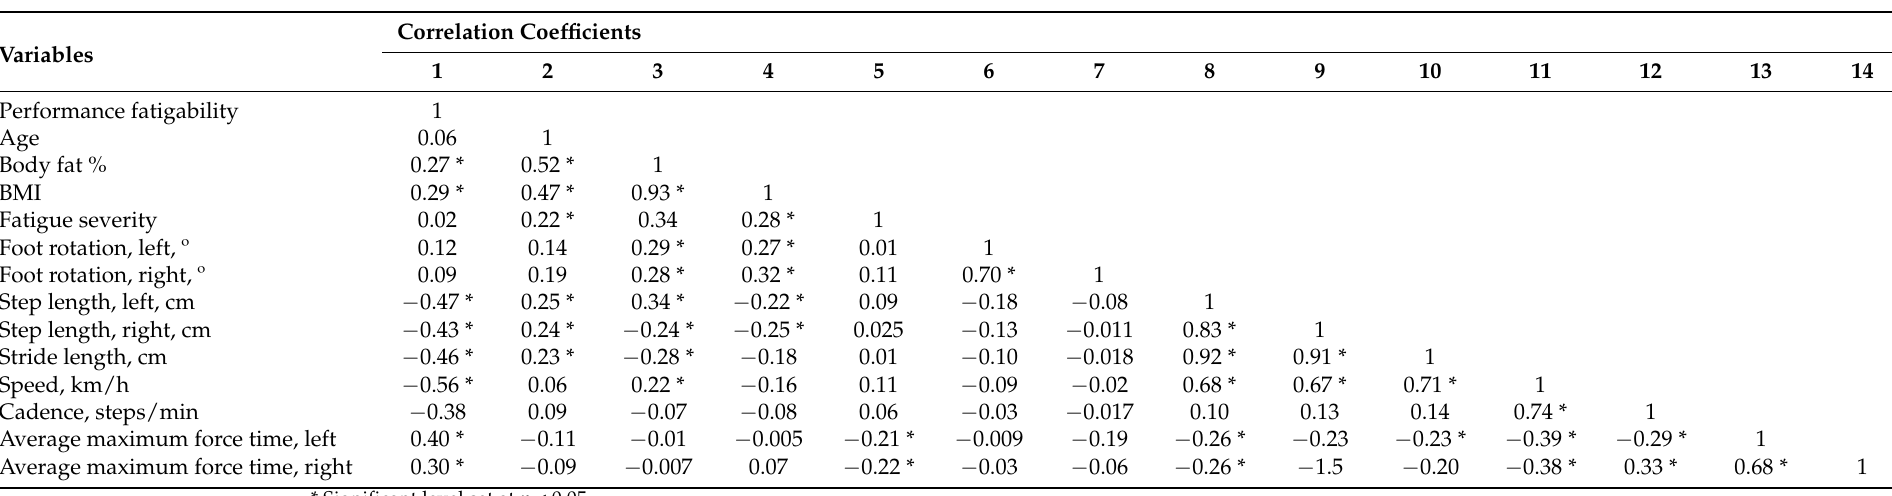
Table 4. A matrix of the Pearson correlation coefficient (r) between the gait characteristic, fatigability, and physical characteristic among the study